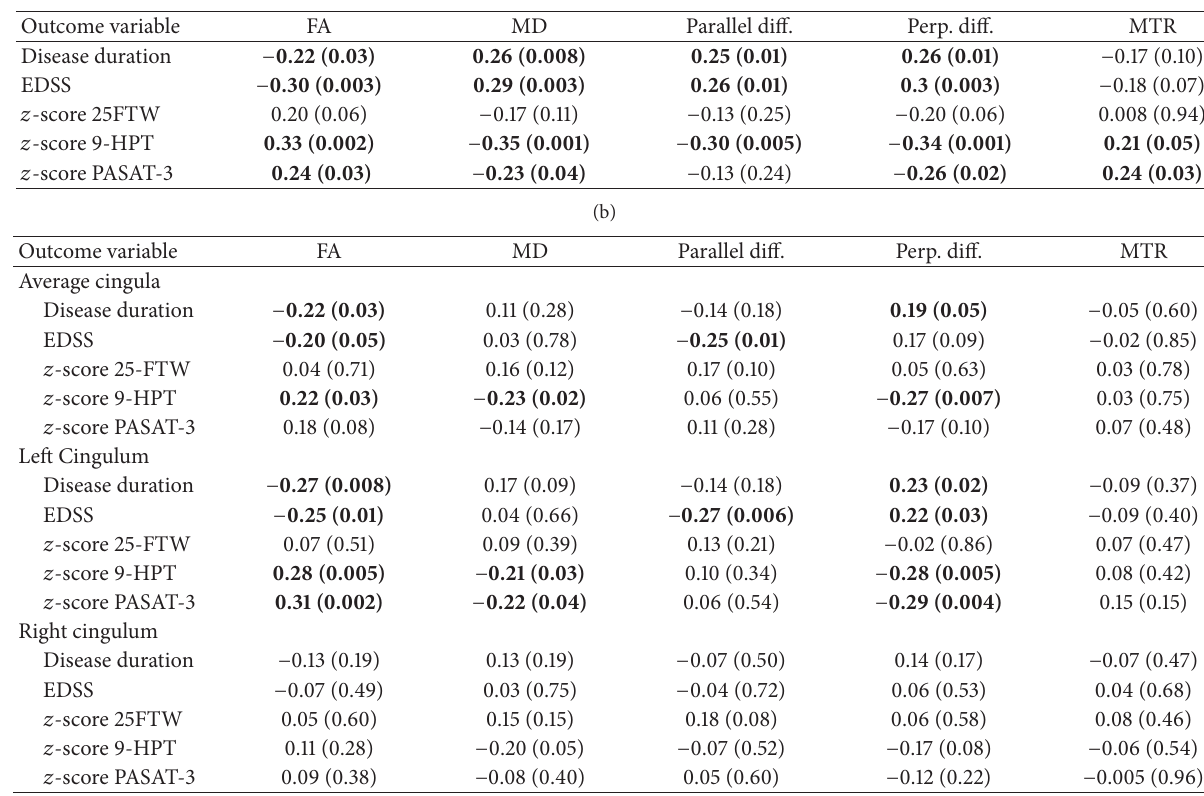
Table 2: (a) Fornix correlations with disability and MSFC. (b) Cingulum correlations with disability and